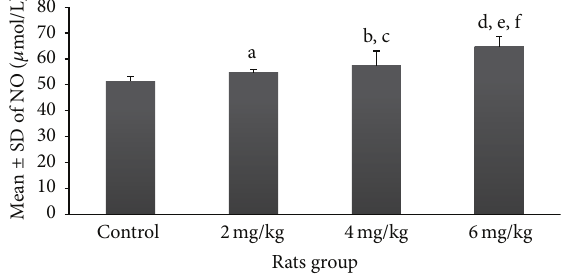
Figure 5: Prenatal exposure to nicotine in pregnant rat increased inflammatory marker nitrite oxide in newborn rats. Mean ± SD of the NO marker in different groups of newborn rats. 𝑁 = 8 (a: 𝑃 > 0.05 in 2 mg/kg group versus control group; b and c: 𝑃 < 0.05 and 𝑃 > 0.05 in 4mg/kg group versus control group and 2mg/kg group, resp.; d, e, and f: 𝑃 < 0.001 , 𝑃 < 0.001 , and 𝑃 < 0.05 in 6 mg/kg group compared to control, 2mg/kg, and 4 mg/kg groups,